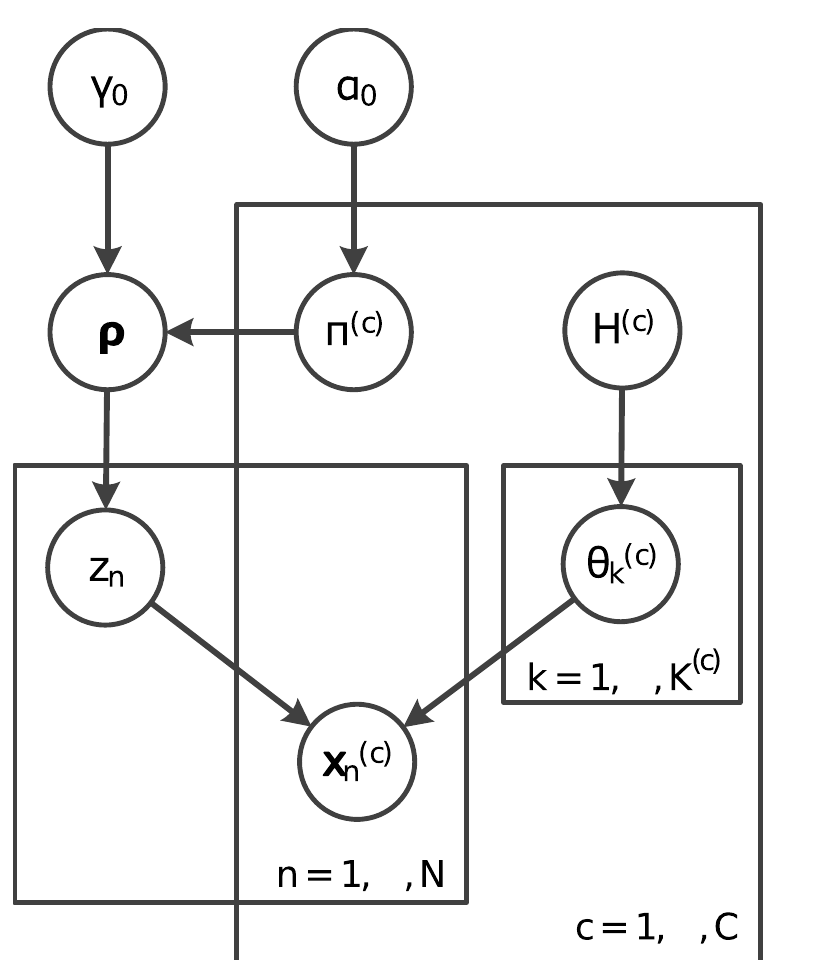
Fig 22. Graphical model representation of the fully combinatorial context-dependent clustering